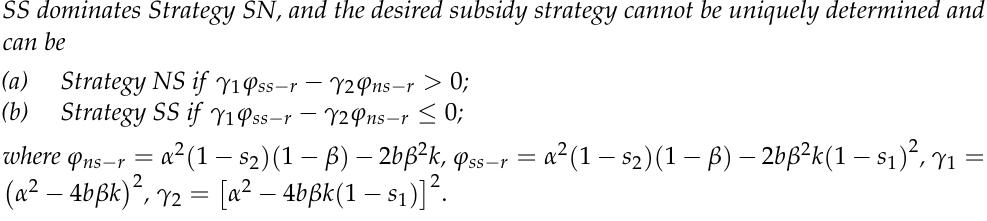
θ θ θ on the profits of manufacturer. on the profits of manufacturer. on the profits of manufacturer. Figure 10. The impact of parameter θ on the profits of